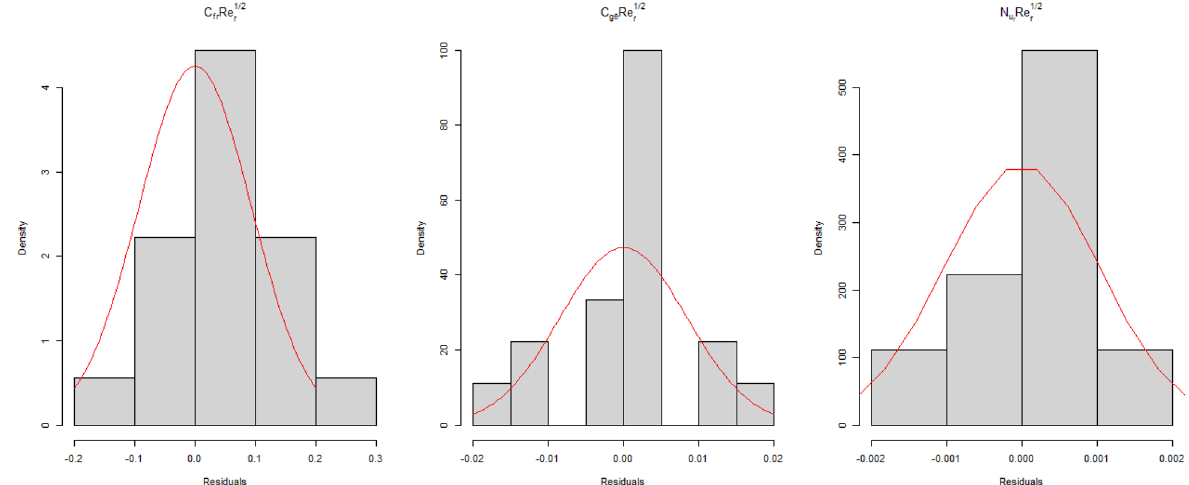
Figure 9. The distribution of residuals from all fitted models is presented here. Indicating all the residuals are normally